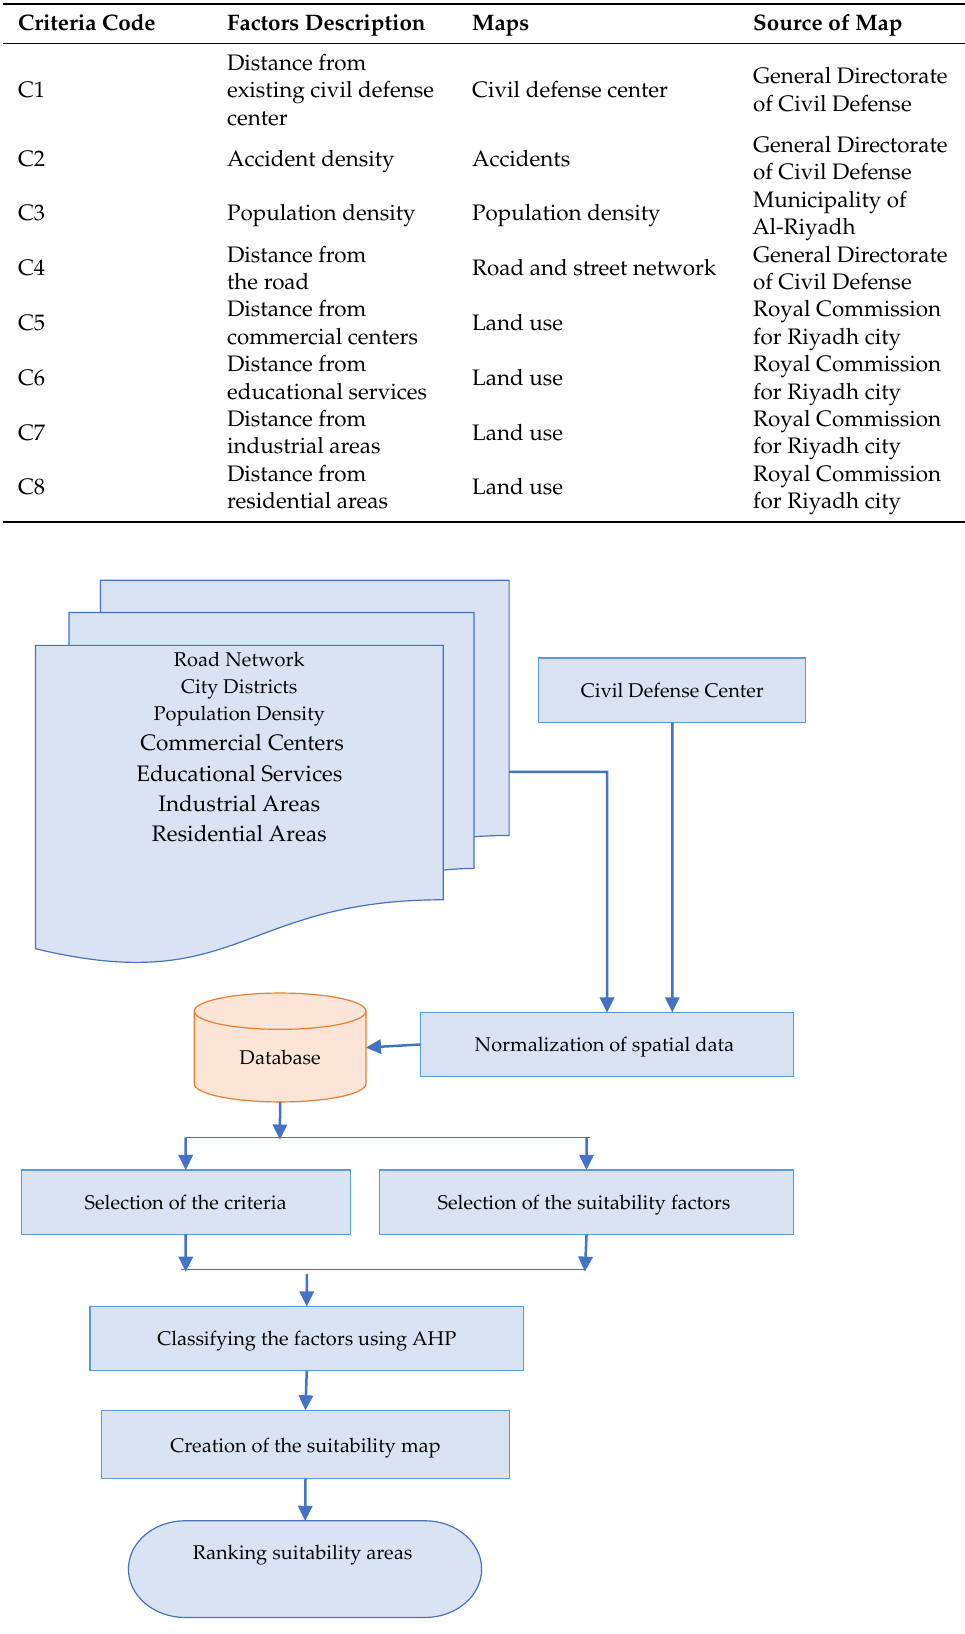
Figure 3. The workflow used.